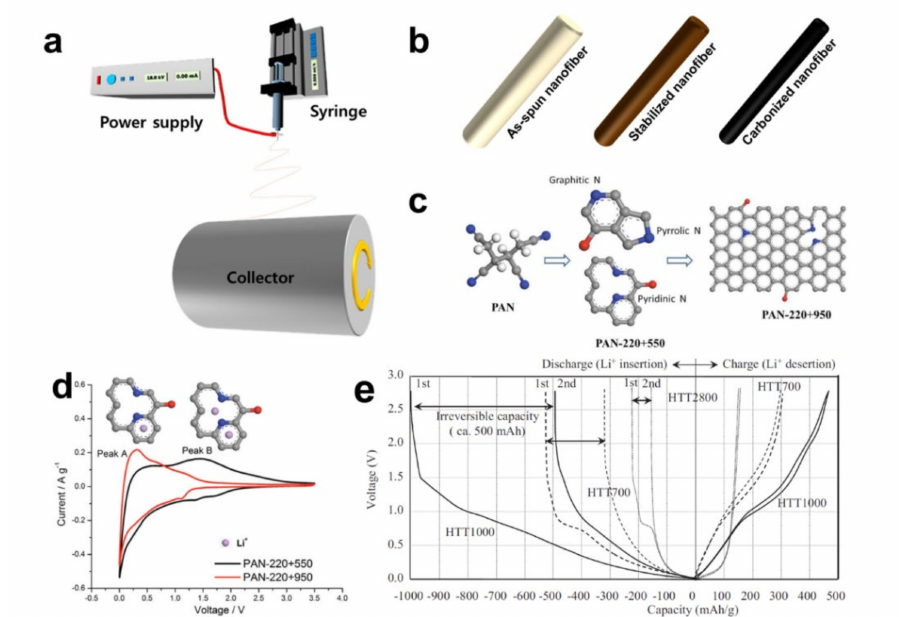
Figure 2. Schematic diagrams of ( a ) electrospinning process, ( b ) morphological changes of nanofibers during thermal treatment, and ( c ) proposed atomic arrangements. Reprinted with permission from